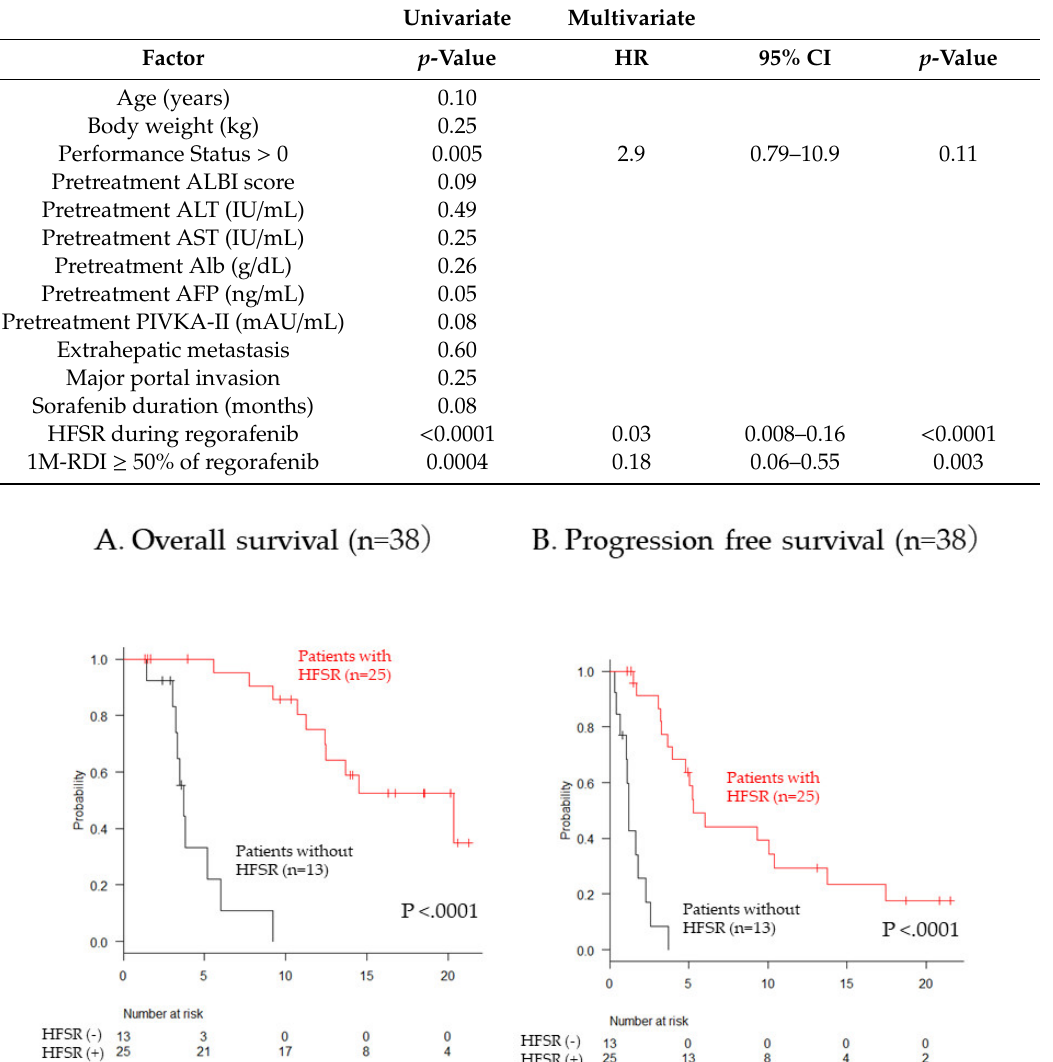
Table 5. Factors associated with overall survival in regorafenib therapy.